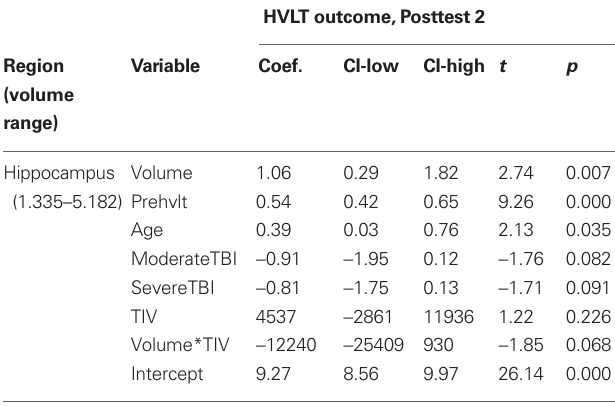
Table 4 | All model terms for the primary prediction analysis, pooling across left and right hippocampal gray matter